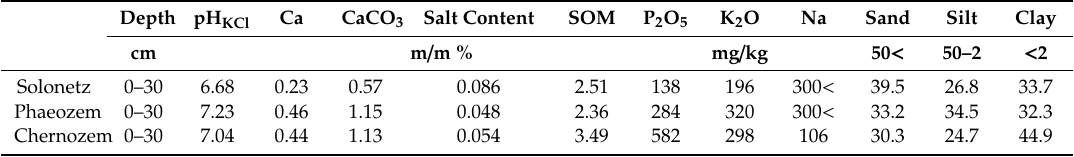
Table 1. Main properties of the investigated topsoils. SOM: soil organic matter. The particle size classes are in µ